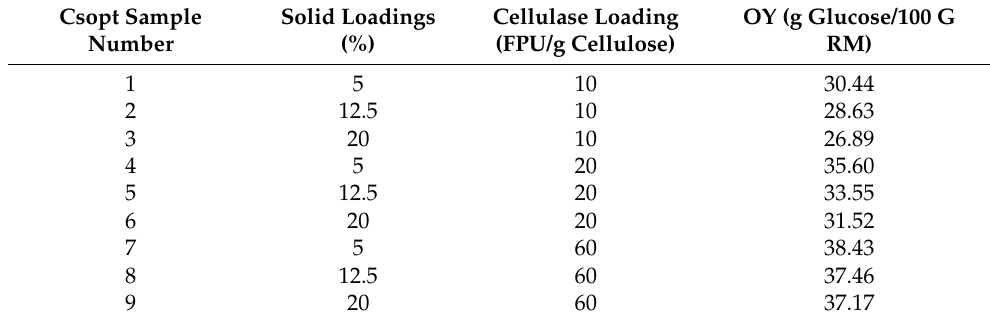
Table 6. Overall yield (OY) obtained for the CSopt sample with different enzymatic hydrolysis conditions. Csopt Sample